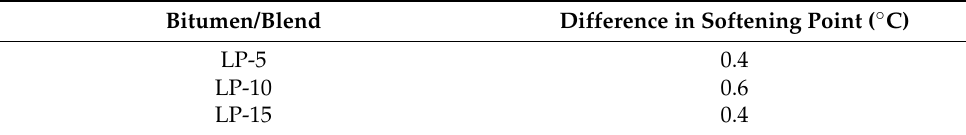
Table 6. Storage stability